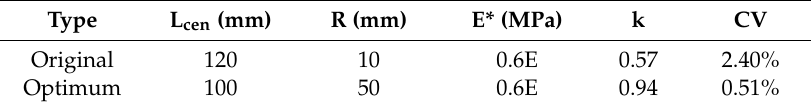
Table 5. Parameter value for the optimum specimen (load ratio = 1:1). Table 5. parameter value for the optimum specimen (load ratio = 1:1).